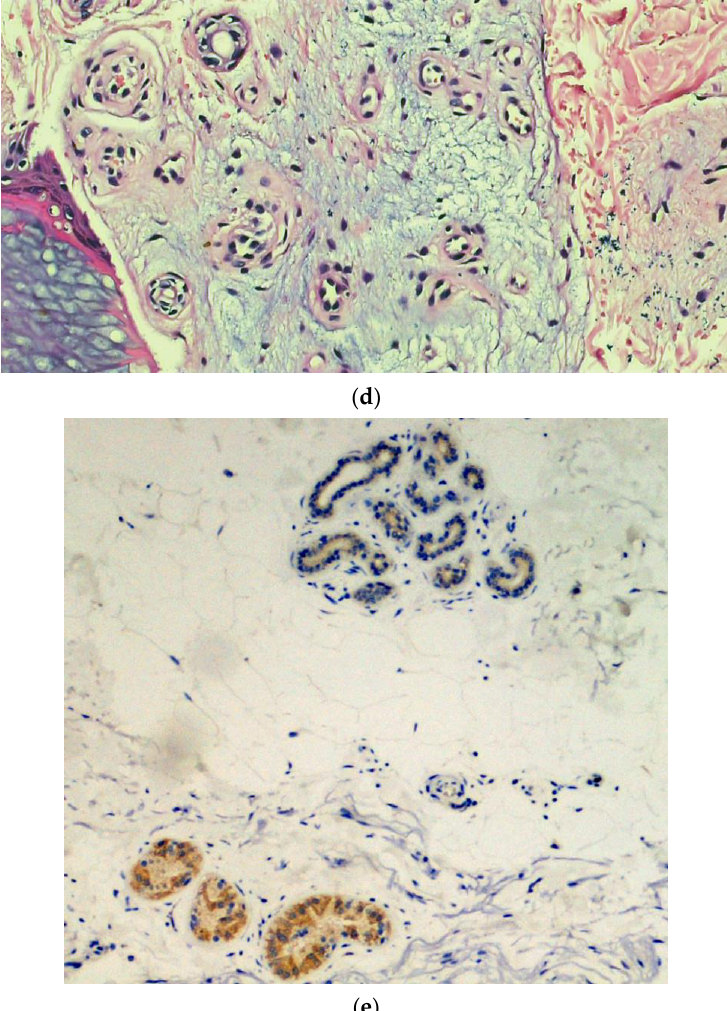
Figure 2. ( a ) Example of erythematous nodules that were hard, elastic, and painless on palpation, present on the lateral surface of the feet. ( b ) Histopathological overview of acral lesions (H&E, original magnification, 100×). ( c ) Details of fragmentation and final dissolution of the collagen and elastic fibers, with the formation of blackish detritus. Presence of reactive fibroblasts. ( d ) Detail of blood vessels with a prominent endothelium of hobnail type. (H&E, original magnification 400×). ( e ) Positive immunostaining in eccrine sweat glands (original magnification, 200×). The last three patients had maculopapular lesions, with no clinical or histological data suggesting a specific dermatosis. However, despite the lack of specific characteristics, immunohistochemistry and PCR conducted on the skin biopsies obtained from these patients showed a strong positivity for viral spike proteins, further confirming the presence of the virus in the skin (Figure 3).